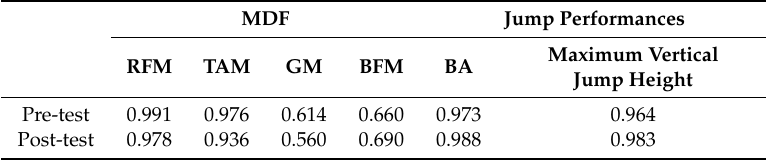
Table 2. The pre- and post-test intra-class correlation coe ffi cient (ICC) for the MDF (RFM, TAM, GM, and BFM) and jump performances (blocking agility (BA) and maximum vertical jump